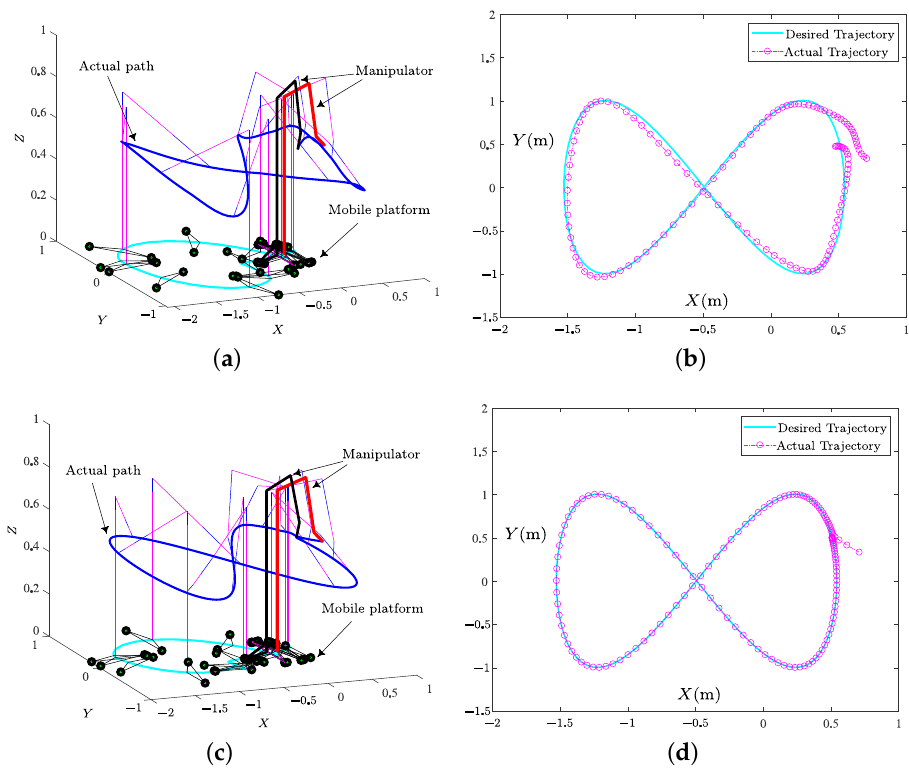
Figure 5. The space trajectory, plane actual trajectory, and plane desired trajectory of the butterfly using the LTCZNN model and the DFZNN model under noise δ i ( t ) = 0.3sin ( 5 t ) . ( a ) By the LTCZNN model. ( b ) By the LTCZNN model. ( c ) By the DFZNN model. ( d ) By the DFZNN model.